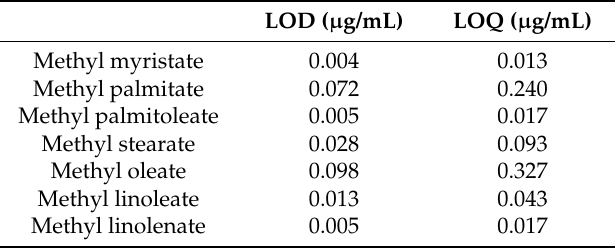
Table 1. Aliquots of frozen oil samples were used as quality control samples. Table 1. Limit of detection and limit of quantitation values for the determination of methylated fatty acids in palm